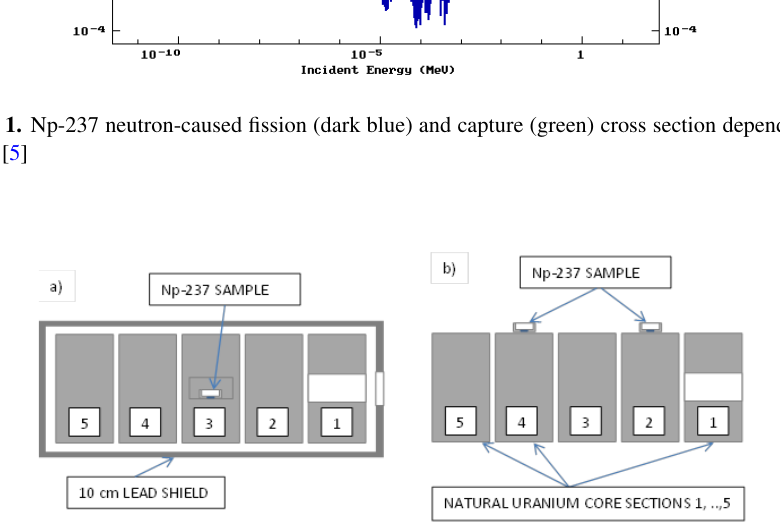
Figure 2. QUINTA setup vertical-axial cross section – configured with lead shield(a) and without it